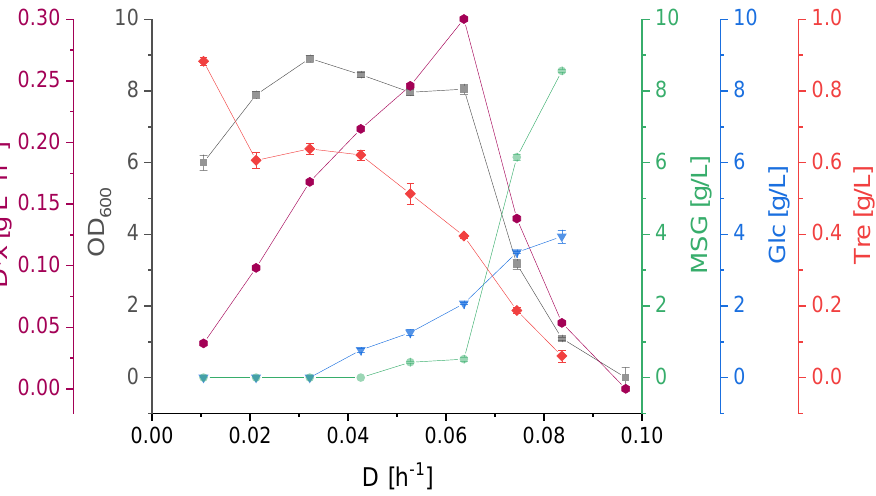
Figure 4. D-x graph: space time yield (D*x) and cell density (OD 600 ), monosodium glutamate (MSG), D-glucose concentration (Glc) and trehalose (Tre) concentration in the supernatant as a function of the applied dilution rate (D). Error bars indicate the difference between the various sampling points after reaching steady state in the continuous cultivation.